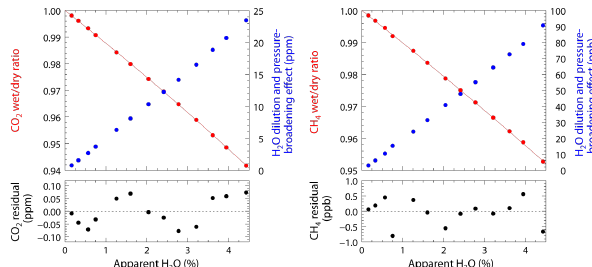
Figure 5. The response of CO 2 and CH 4 against apparent water vapor concentration (values obtained from WS-CRDS measurements (model G-1301)) along with the residuals from the fitting functions. The wet/dry ratio (left y -axis) indicates the ratio of the measured mixing ratio of the target gases in the wet and dry sample air, and the corresponding water vapor dilution and pressure-broadening effects (right y -axis) are defined as the difference between the dry and wet mixing ratios of the target gases. The solid red lines are fitting curves for the wet/dry ratios with parameters listed in Table 3.